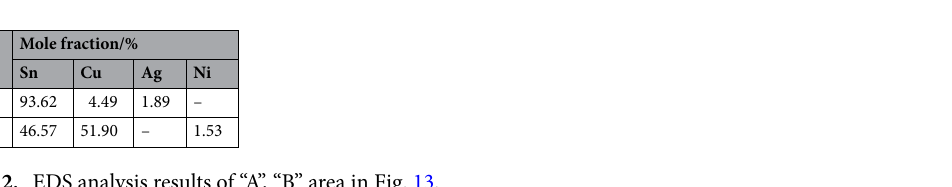
Table 2. EDS analysis results of “A”, “B” area in Fig. 13.